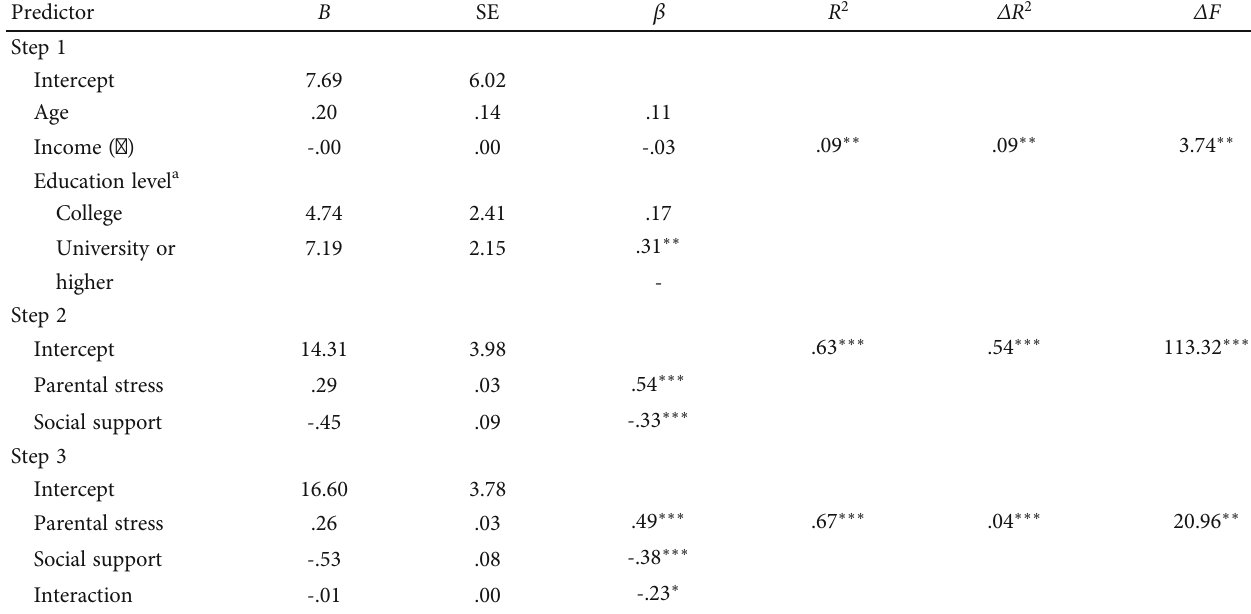
Table 4: Hierarchical multiple regression analyses testing moderating e ff ect of social support in the relationship of parental stress and